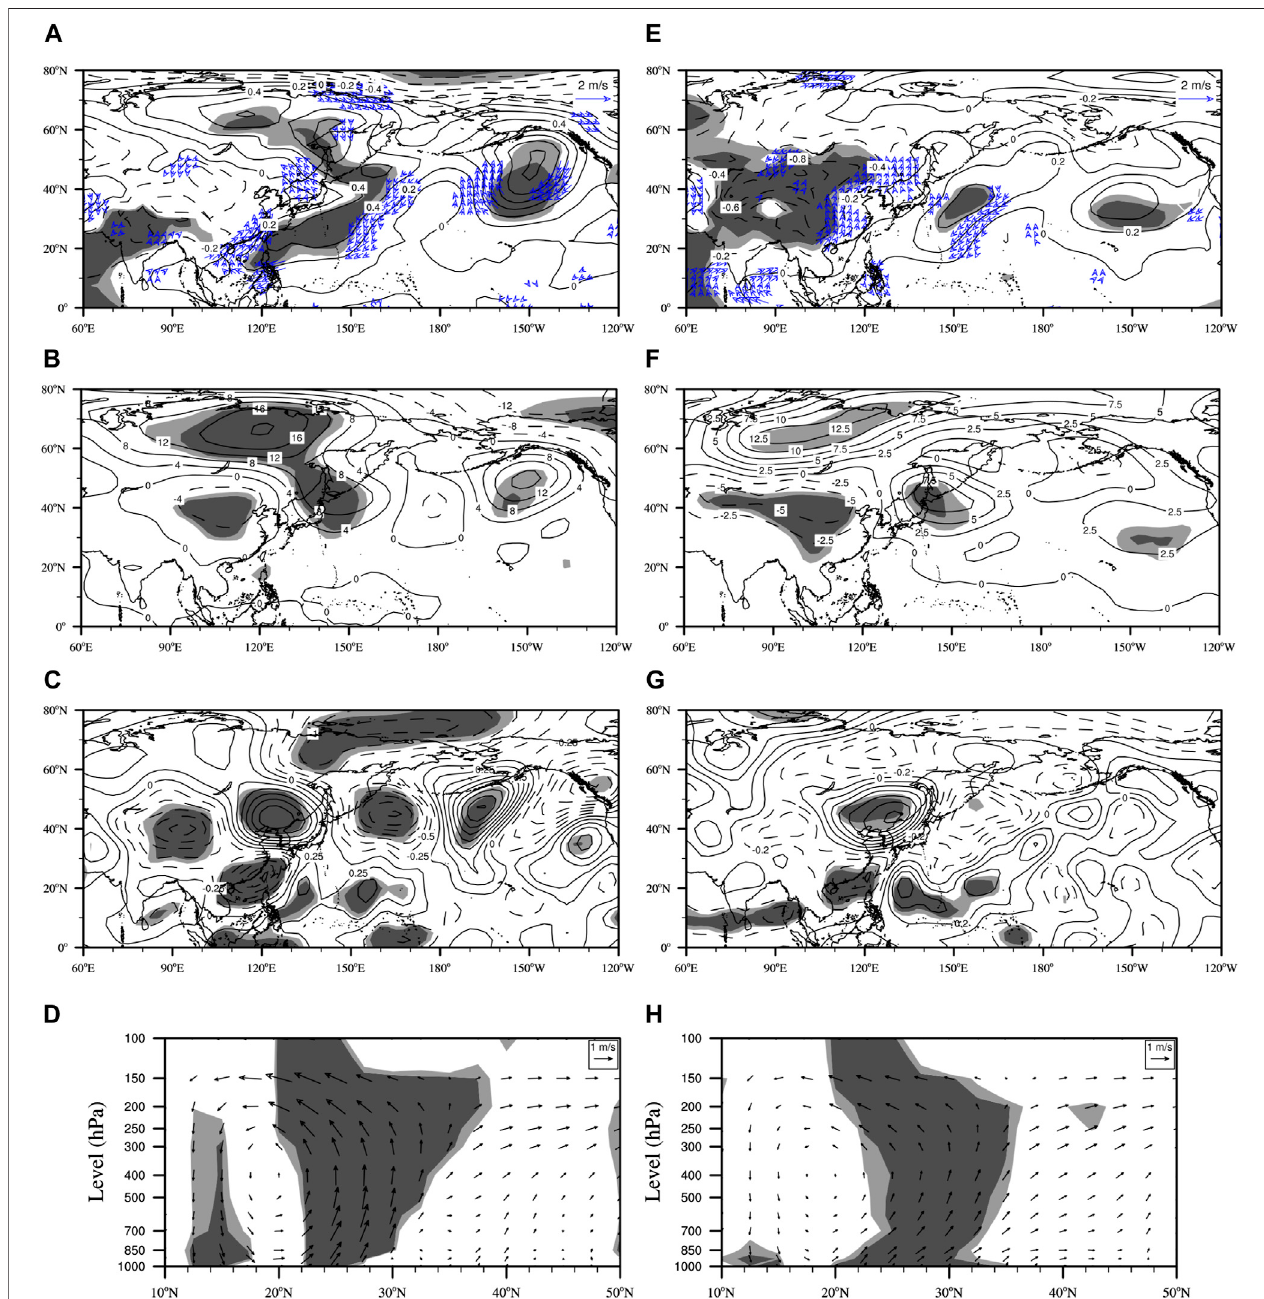
FIGURE 5 | Regressed (A) SLP (unit: hPa; contours) and 850 hPa wind (unit: m s − 1 ; vectors), (B) 500 hPa geopotential height (unit: m; contours), (C) 200 hPa meridional wind (unit: m s − 1 ; contours), and (D) latitude – pressure section of 110 ° – 118 ° E mean vertical circulation (unit: meridional wind ms − 1 , vertical velocity − 0.01 Pa · s − 1 ; vectors) against the SCPI, (E – H) same as (A – D) but for the APOI (dark (light) shadows represent the 95% (90%) con fi dence